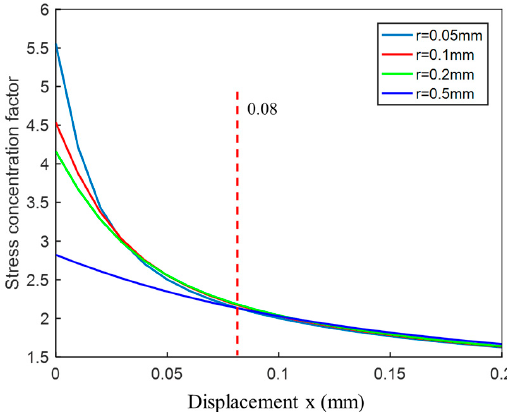
Figure 11. Processing and fatigue test of round bar and CT specimens (units, mm). ( a ) the dimensions of the round bar specimen. ( b ) the dimensions of the CT specimen [54].